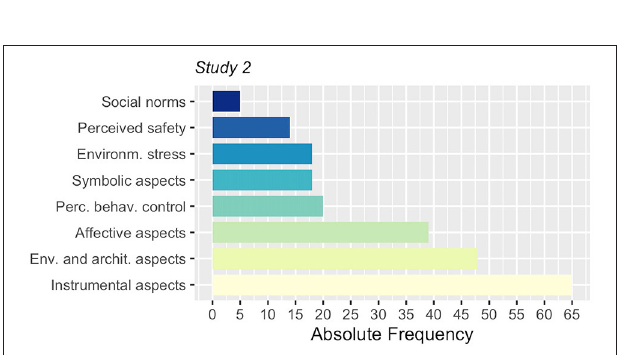
FIGURE 4 | Frequency of socio-psychological, environmental and architectural topics of the group discussions in Study